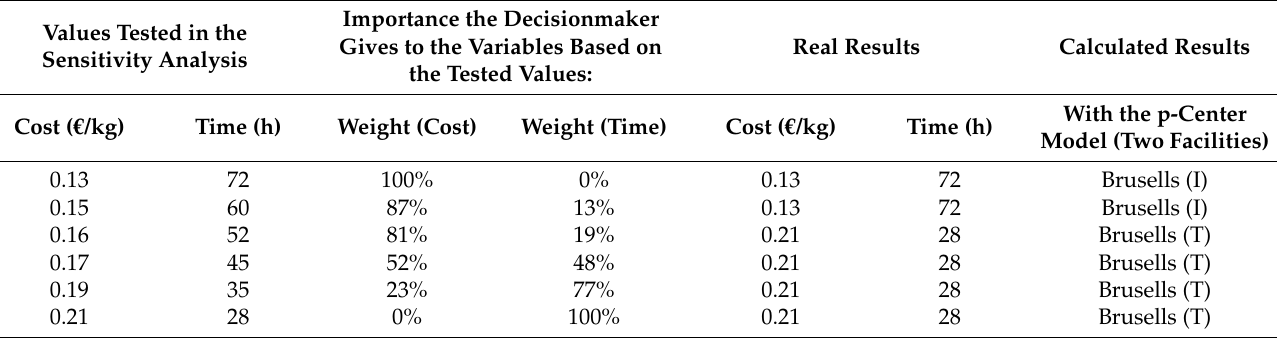
Table 4. Sensitivity